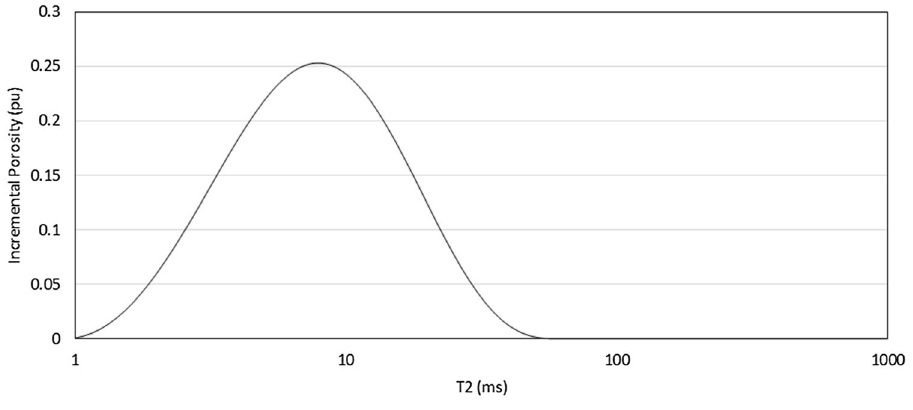
Fig. 1 T 2 distribution curve (100% saturation-sample 33)